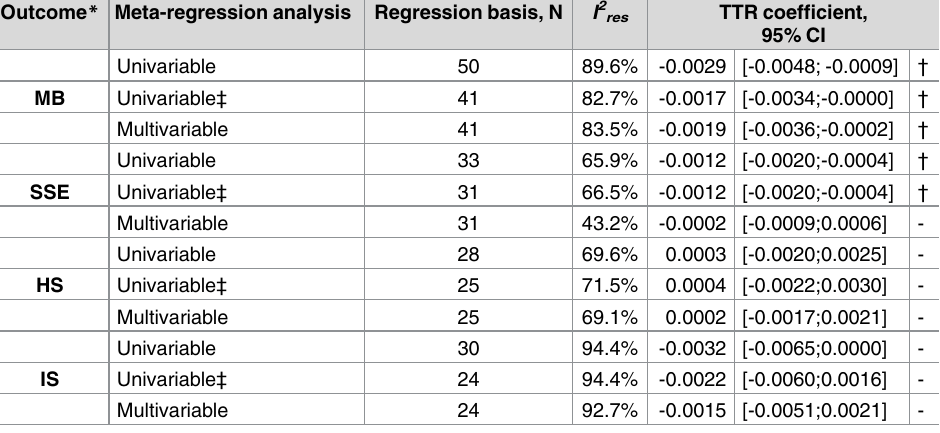
Table 2. Results of univariable and multivariable random-effects meta-regressions of the impact on outcomes of mean time in therapeutic range. Outcome * Meta-regression analysis Regression basis,